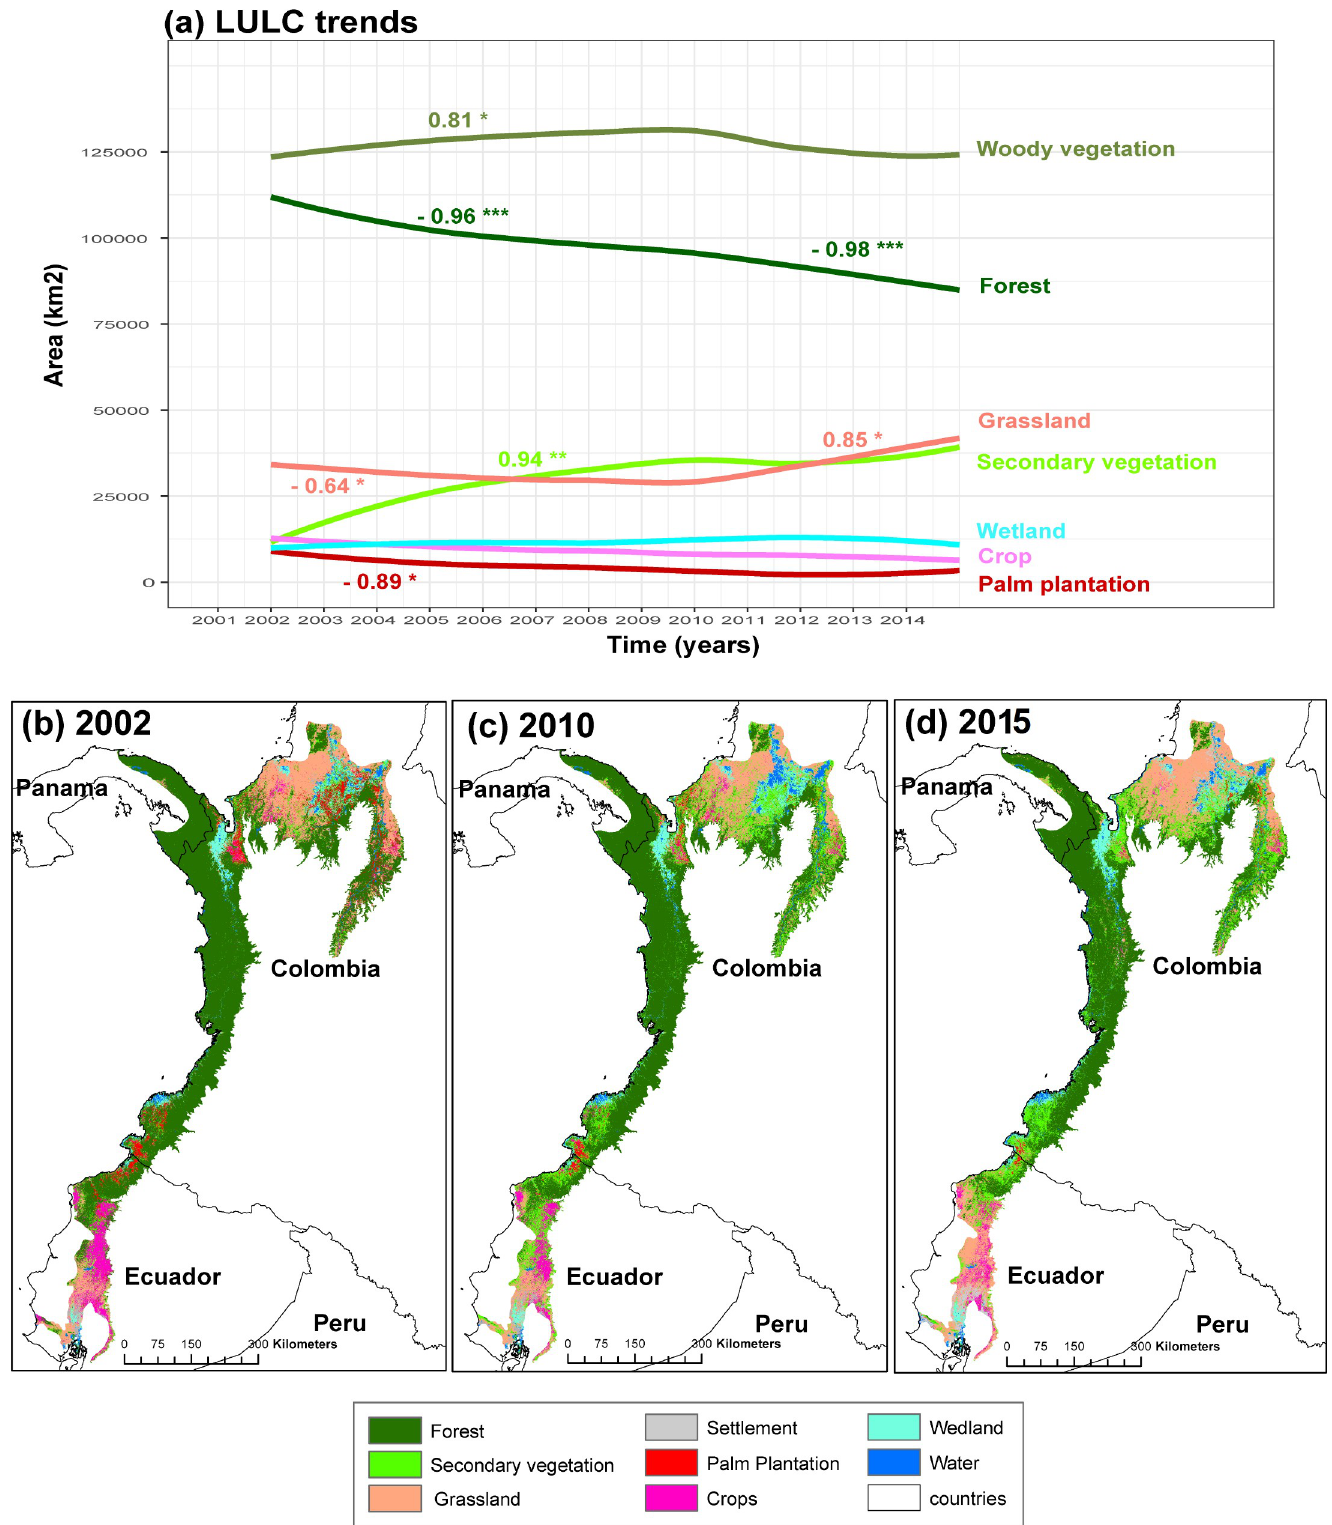
Fig 3. Land-use and land-cover (LULC) change trends in The Choco´-Darien Global Ecoregion (CGE). Significant correlation coefficients (R) are shown for the two temporal periods 2002–2010 and 2010–2015 (a). Significant P range values; P < 0.001( ��� ), P < 0.01( �� ), and P < 0.05( � ). LULC maps for 2002, 2010 and 2015 are showed (b, c,